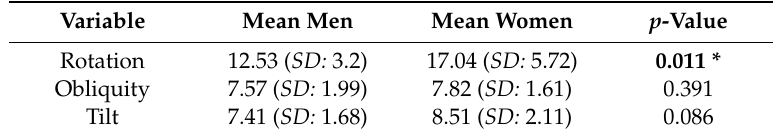
Table 3. Di ff erences between men and women in the kinematics of the pelvis during sprinting at a self-selected speed *.